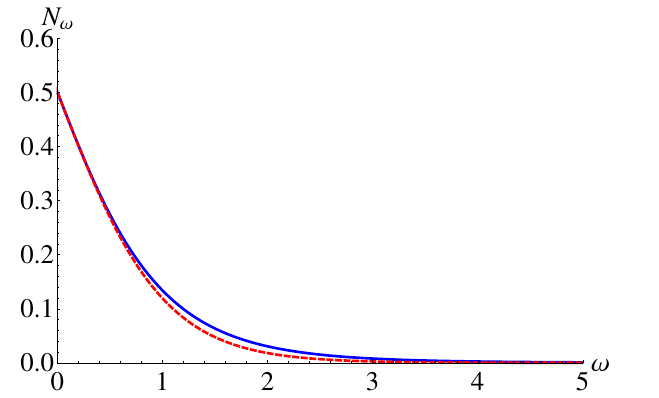
of the Unruh radiation, computed (cid:12)